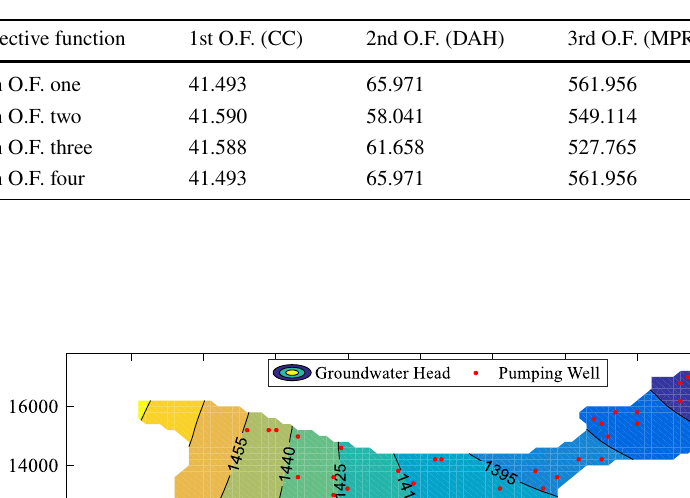
Objective function